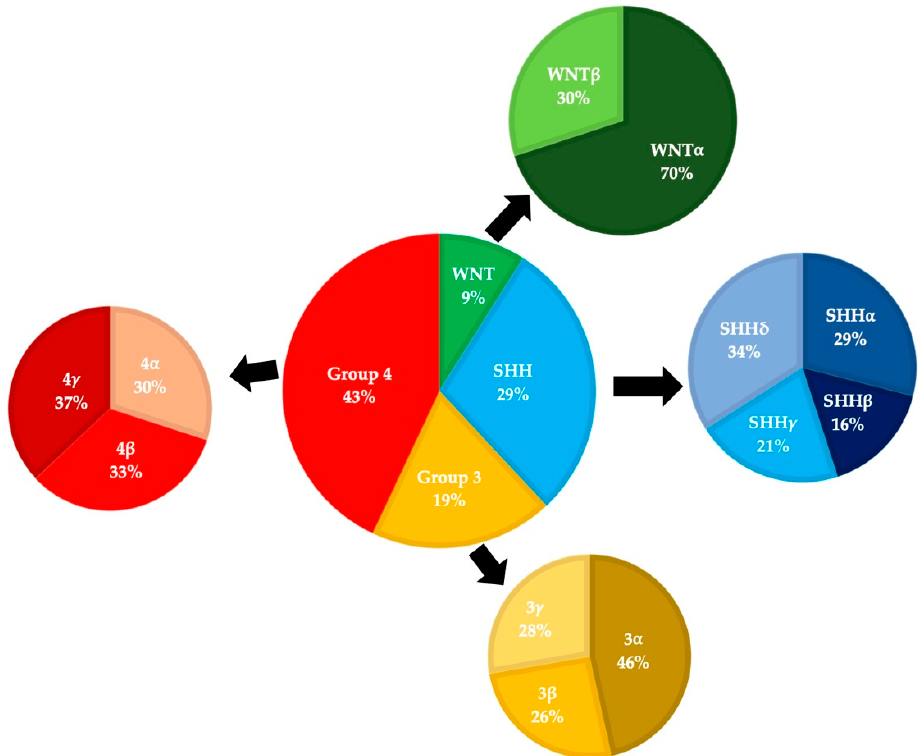
Figure 2. Subgroups and subtypes across the age spectrum. Figure 1. Subgroups and subtypes across the age spectrum.